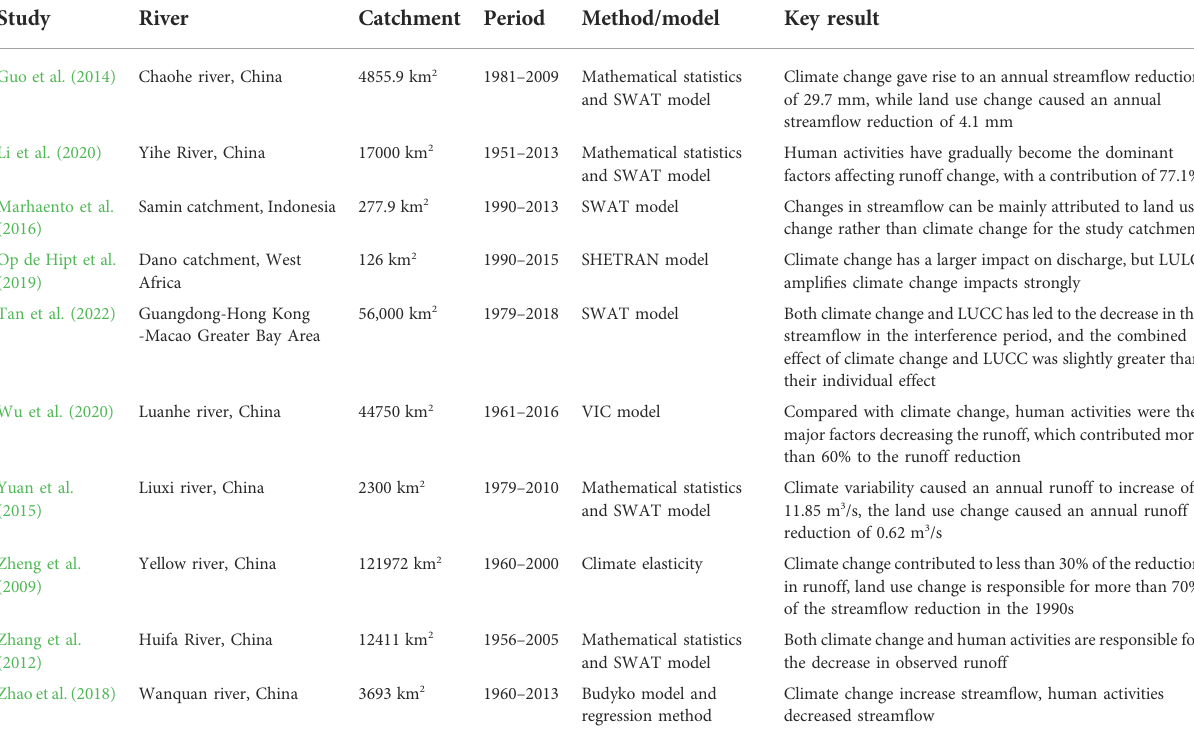
TABLE 6 Summary of relevant literature on runoff change of climate and LUCC in relation to the objectives of this